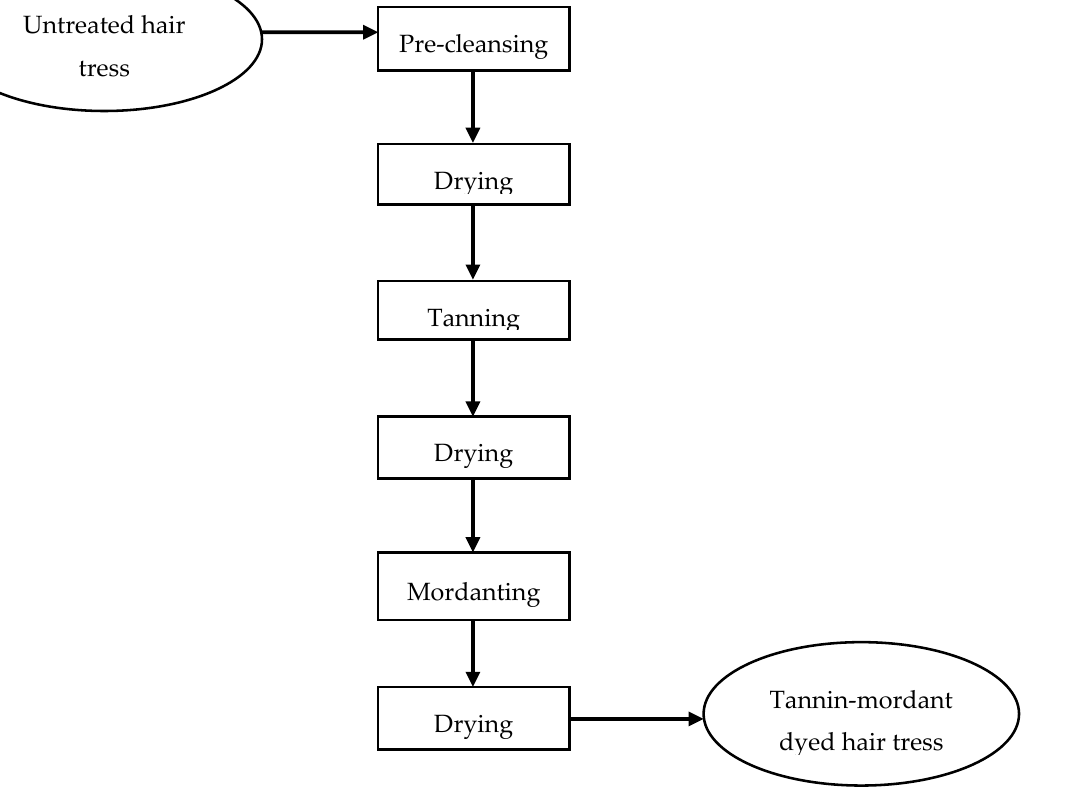
Figure 8. Flowchart of complete dyeing method.